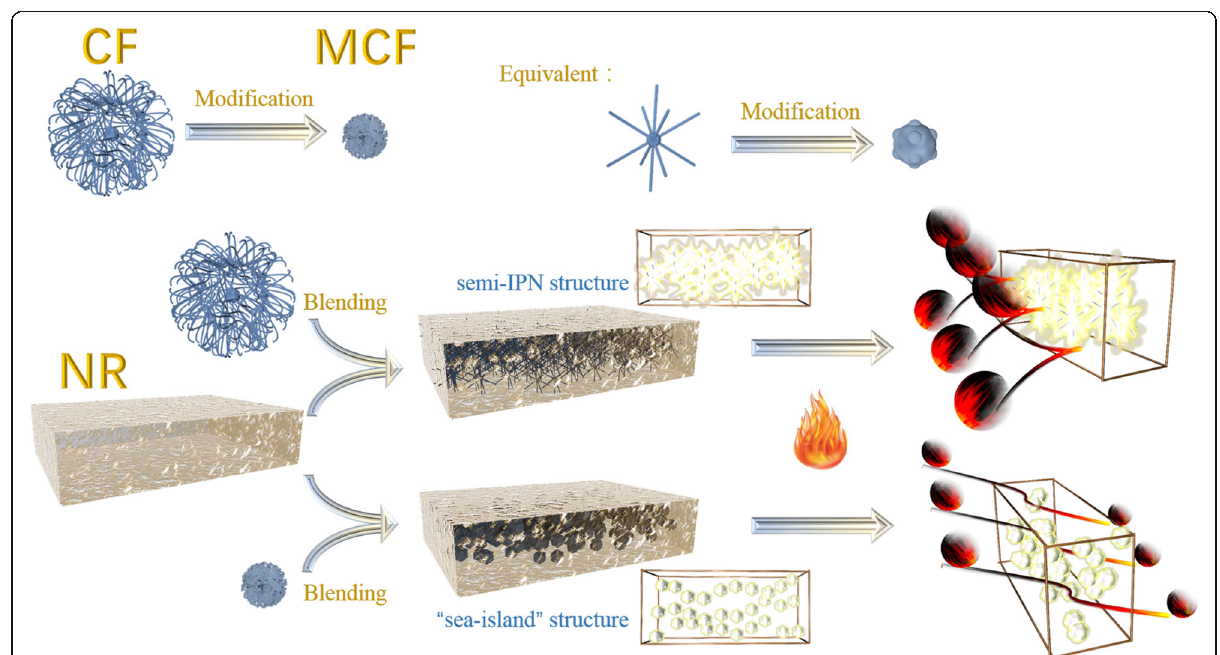
Fig. 8 The action mechanism and effects of CF and MCF in flame retardancy